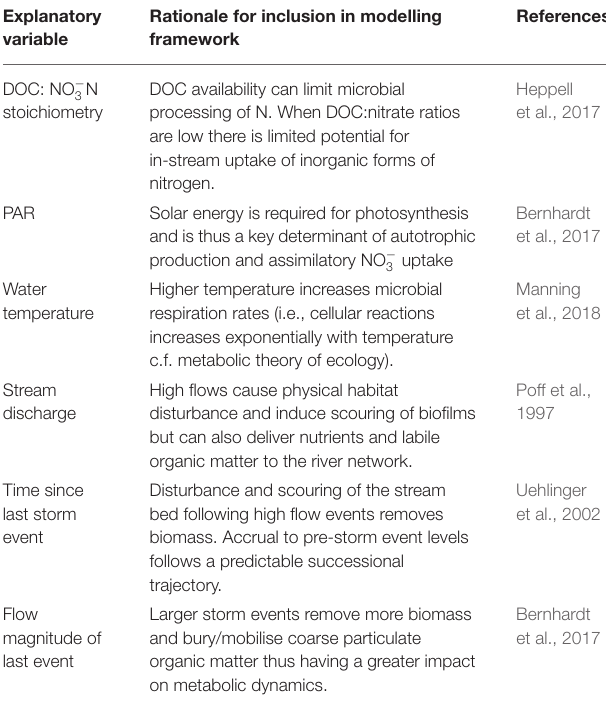
TABLE 1 | Explanatory variables retained for the final model selection process with rationale for their